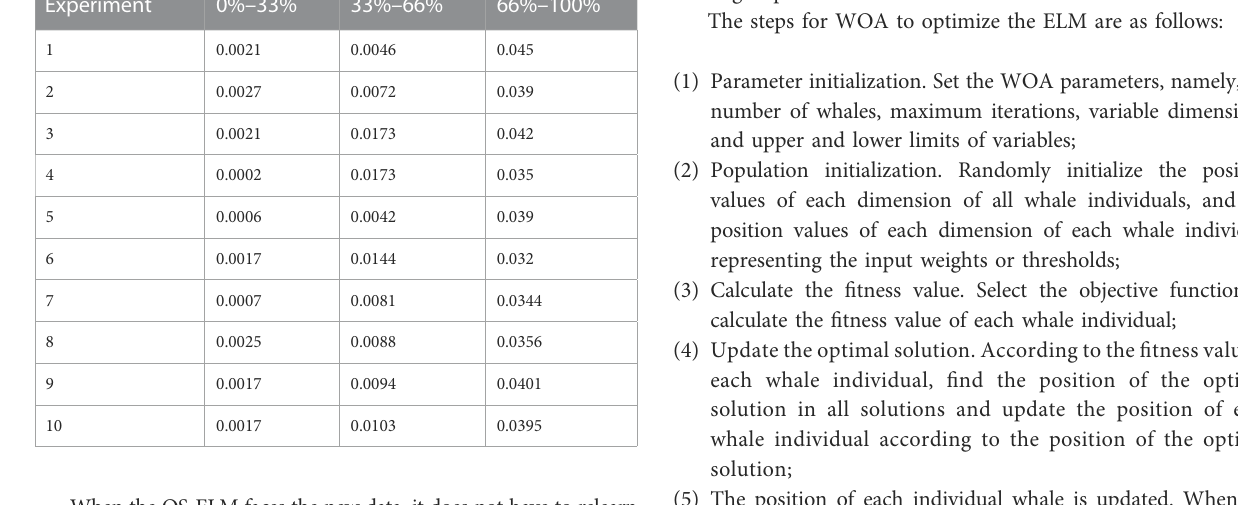
TABLE 2 Distance interval testing error through B1 data.